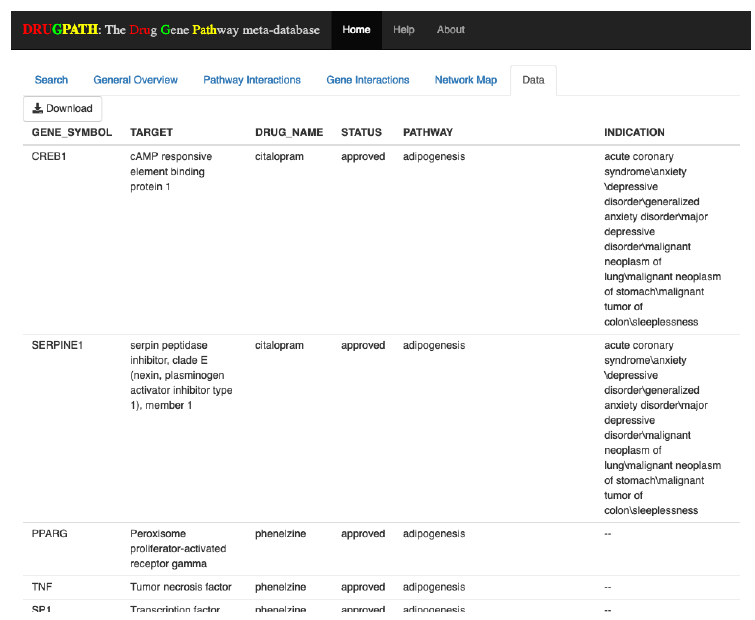
Figure 6. Data available for download.